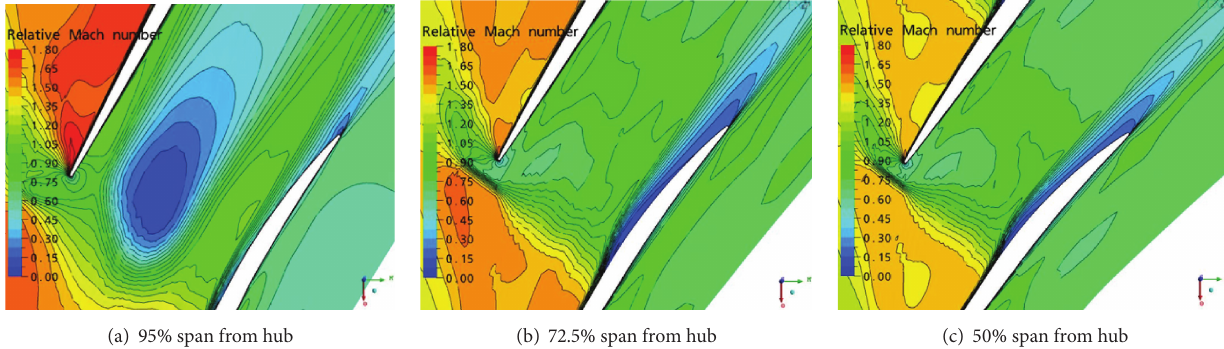
Figure 11: Relative Mach number distribution in the blade passage of baseline rotor at three spanwise locations from hub (100% design rotational speed, near-stall mass flow rate). Table 2: Performance of compressor rotor for different aspirated slot configurations (100% design rotor speed). Configuration details